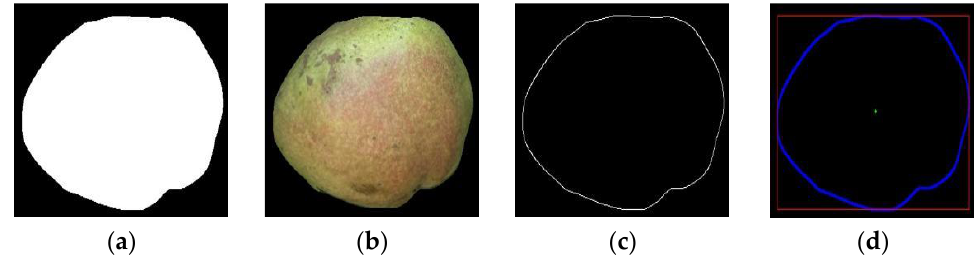
Figure 8. Centroid of Camellia oleifera fruit. ( a ) Median filtering, ( b ) Mask extraction, ( c ) Canny, ( d ) Centroid.